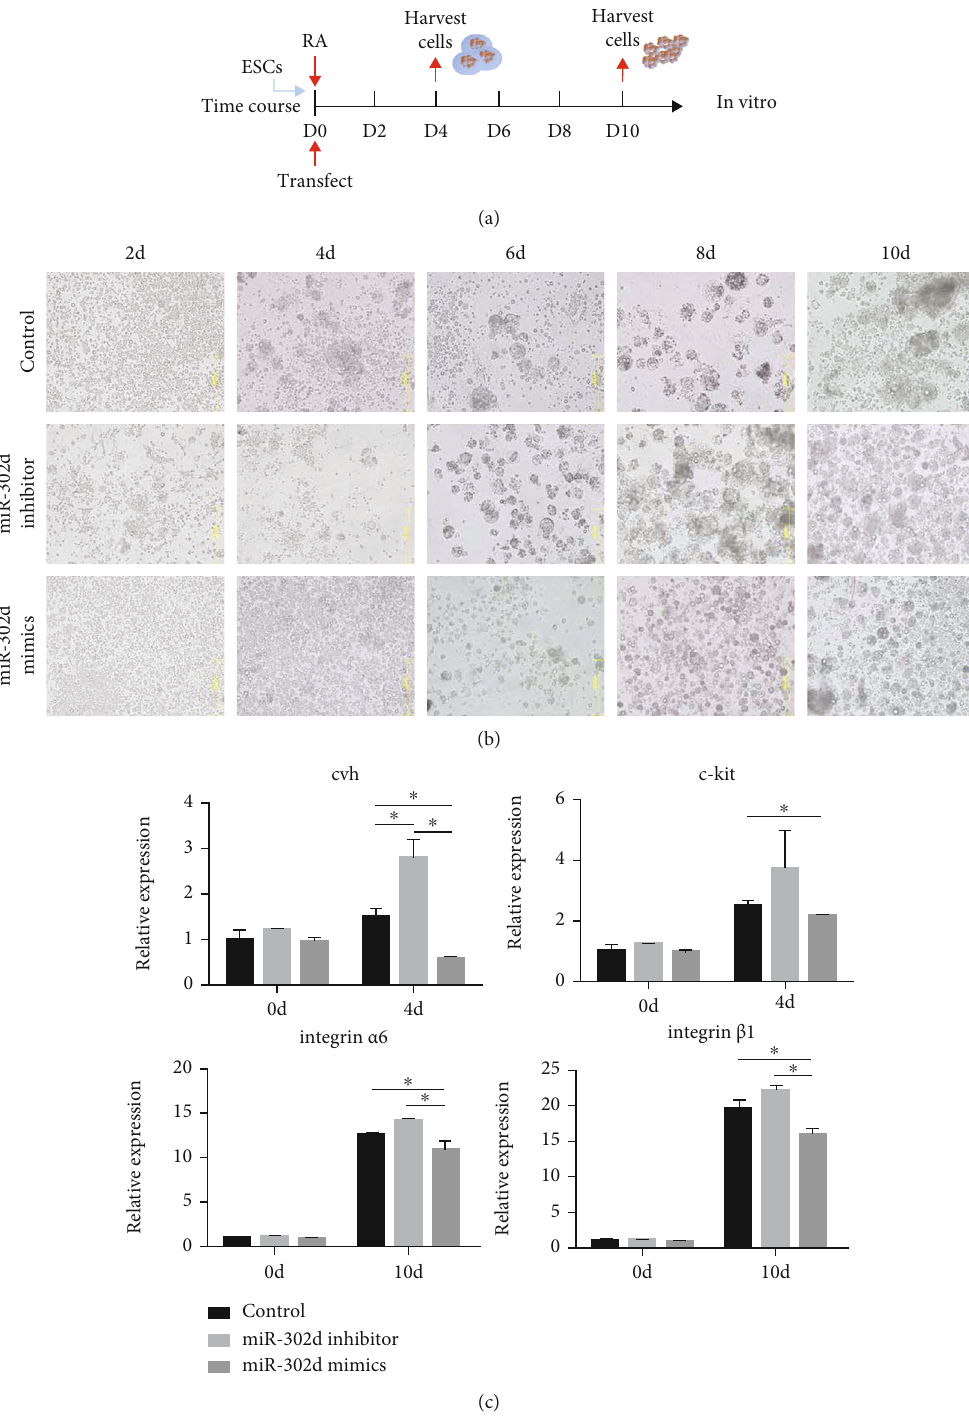
Figure 2: miR-302d function veri fi cation in vitro. (a) Experimental scheme in vitro. (b) Cell morphology every two days, control: inducing by RA; miR-302d inhibitor: based on RA induction, miR-302d inhibitor lentivirus was infected on day 0; miR-302d mimics: based on RA induction, miR-302d mimics lentivirus was infected on day 0. (c) mRNA expression levels of marker genes were detected on day 4 and day 10; cvh and c-kit were used as PGC maker genes in chicken, integrin α 6 and integrin β 1 were SSC maker genes, and β -actin was the reference